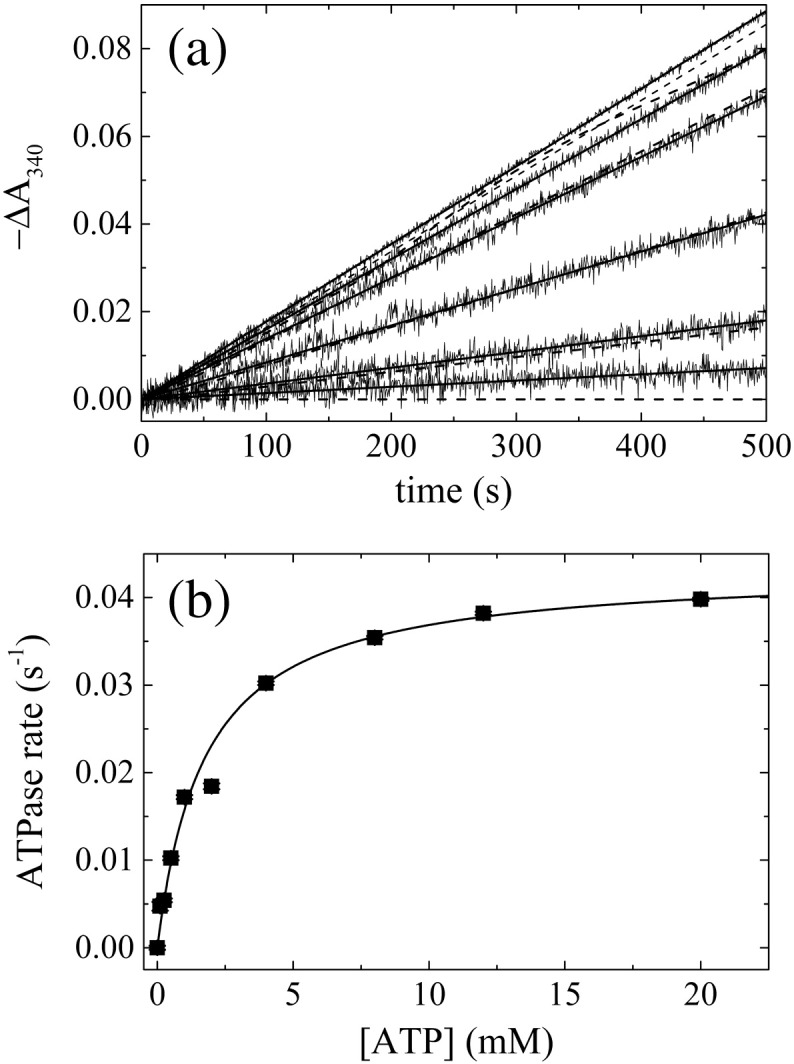
Steady-state ATPase activity of Dbp5. (a) Time courses of absorbance change at 340 nm assayed with the NADH-coupled assay after mixing 660 nM Dbp5 with (lower to upper curves) 0, 0.25, 0.5, 1, 2, 8, or 20 mM ATP. The continuous lines through the data represent the best fits to linear functions, yielding the steady-state ATPase rates from the slopes. Broken lines represent kinetic simulations of Scheme 1 and the corresponding rate and equilibrium constants obtained from global fitting with KinTek Explorer in Table 2. (b) [ATP] dependence of the Dbp5 steady-state ATPase rate. The continuous line through the data represents the best fit to a rectangular hyperbola, yielding the maximum velocity per enzyme (kcat) from the amplitude and the KM,ATP from the [ATP] at half-maximum velocity (Table 1). Uncertainty bars represent standard errors in the fits and are within the data points.